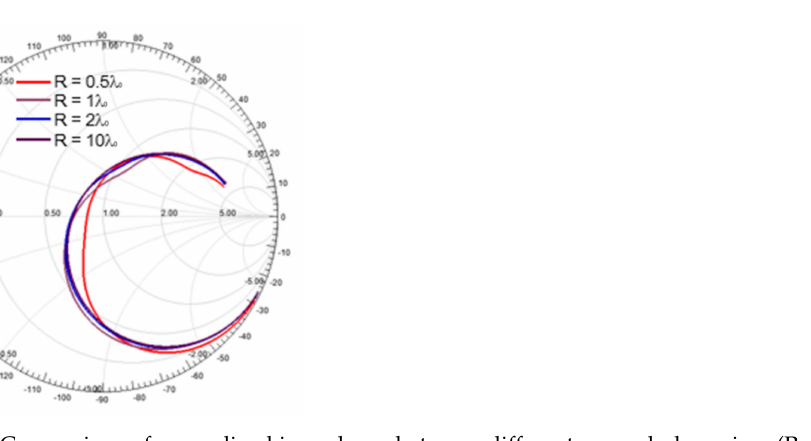
Figure 2. Comparison of normalized impedance between different ground plane sizes (R = 0.5 λ 0 , 1 λ 0 , 2 λ 0 , and 10 λ 0